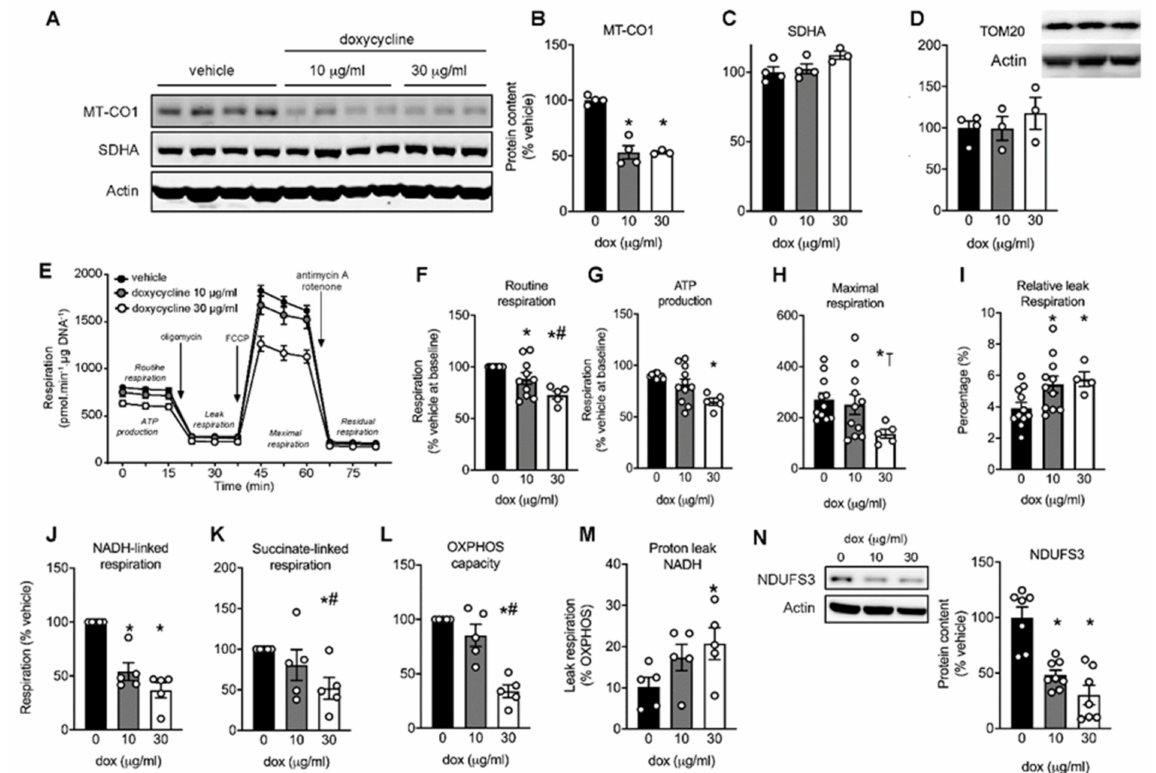
Figure 1. Mito-nuclear protein imbalance and mitochondrial complex I dysfunction in H9C2 cardiomyoblasts exposed to doxycycline. H9C2 cardiomyoblasts were exposed to doxycycline at 0, 10 or 30 µ g/mL for 72–96 h. ( A ) Western blot showing protein expression of mitochondrially-encoded cytochrome c oxidase I (MT-CO1) and nuclear-encoded succinate dehydrogenase complex, subunit A (SDHA). Actin was used as a loading control. ( B ) MT-CO1 protein content (normalized to vehicle) was significantly lower in doxycycline-treated cells. ( C , D ) SDHA and TOM20 protein content is unaffected by doxycycline. ( E ) Typical Seahorse run with injections of oligomycin, carbonylcyanide-4-(trifluoromethoxy)- phenylhydrazone (FCCP), antimycin A and rotenone highlighted. ( F – H ) Routine, oxygen consumption used for ATP production (Routine-Leak respiration) and maximal respiration was reduced in doxycycline-treated cells. ( I ) Normalized leak respiration (i.e., Leak / Maximal respiration) was higher in both concentrations of doxycycline. ( J ) Mitochondrial complex I-stimulated respiration (with substrates pyruvate and malate) was significantly reduced in cells exposed to 10 or 30 µ g/mL doxycycline compared to vehicle. ( K ) Complex II-stimulated (with succinate and rotenone) was only reduced at 30 µ g/mL doxycycline compared to vehicle or low dose doxycycline. ( L ) Oxidative phosphorylation (OXPHOS) capacity (with pyruvate, malate and succinate) dose-dependently decreased following doxycycline exposure, note that panel H shows maximal uncoupled respiration. ( M ) Relative leak respiration (after oligomycin) with complex I substrates showed increased proton leak from complex I at 30 µ g/mL doxycycline. No differences were observed with other substrates. ( N ) Western blot analysis revealed a large reduction in protein content of nuclear-encoded mitochondrial complex I subunit NDUFS3 in doxycycline-treated H9C2 cells. Bar graphs are expressed as mean ± SEM. *: p < 0.05 vs. vehicle, one-way ANOVA followed by Tukey’s post-hoc test for multiple comparisons, #: p < 0.05 vs. 10 µ g/mL doxycycline. (cid:62) : p = 0.088 vs. 10 µ g/mL